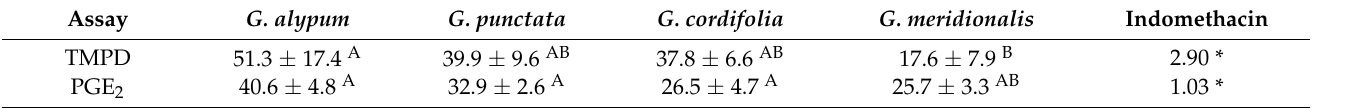
Table 6. COX-1 inhibitory activity (%) of G. alypum, G. punctata, G. cordifolia and G. meridionalis ( GM ) aerial parts extracts (mean values ± SD; n = 3 for TMPD assay; n = 4 for PGE 2 assay; c = 50 µ g/mL).